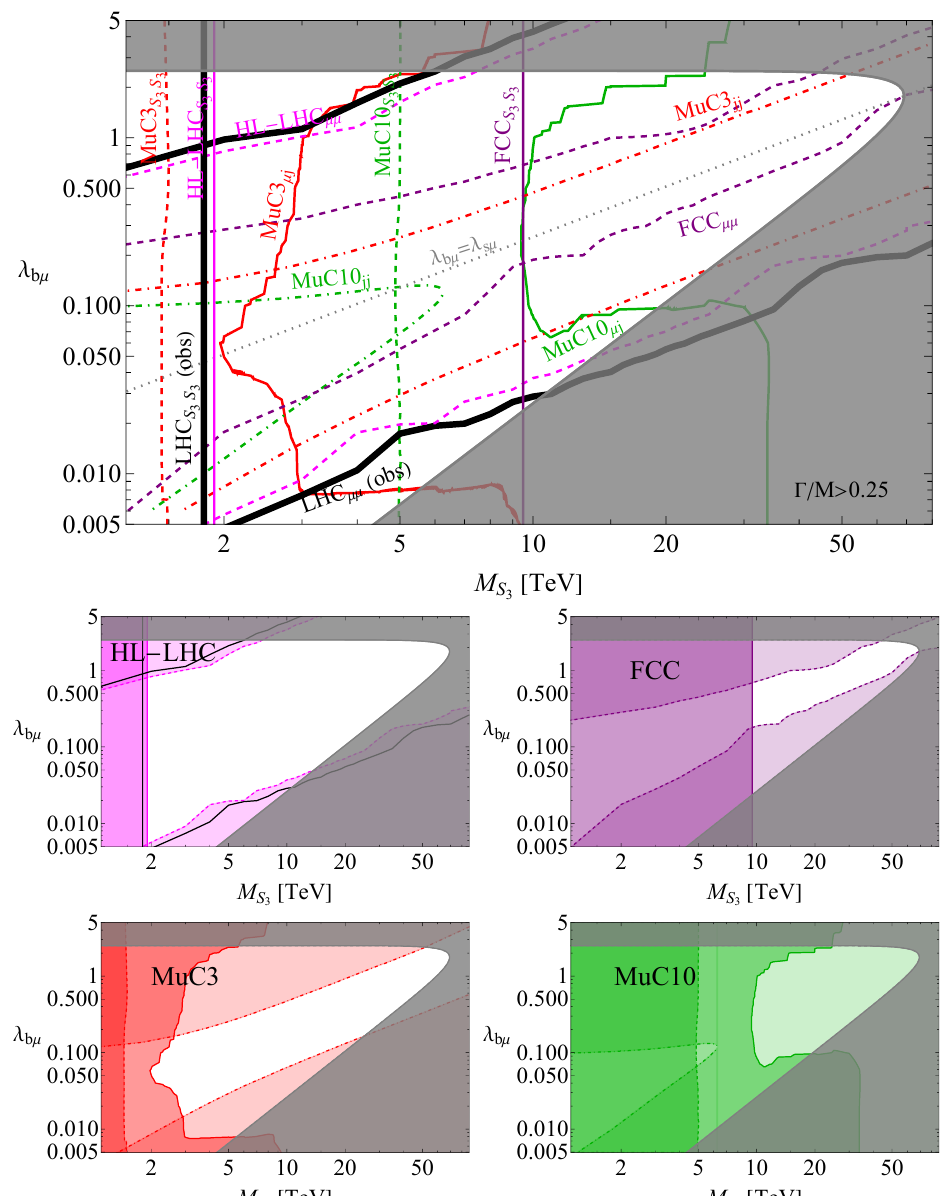
Figure 14 . The 5 σ discovery prospects for the S 3 leptoquark behind to bsµµ anomalies, i.e. imposing eq. (6.6). The present LHC exclusions at 95% CL are shown as a thick black line. The dotted gray line corresponds to λ bµ = λ sµ . The perturbative limit Γ S For future colliders, the discoverable region is on the side of the line where the corresponding label is. The smaller plots below the main one highlight the reach of various future colliders